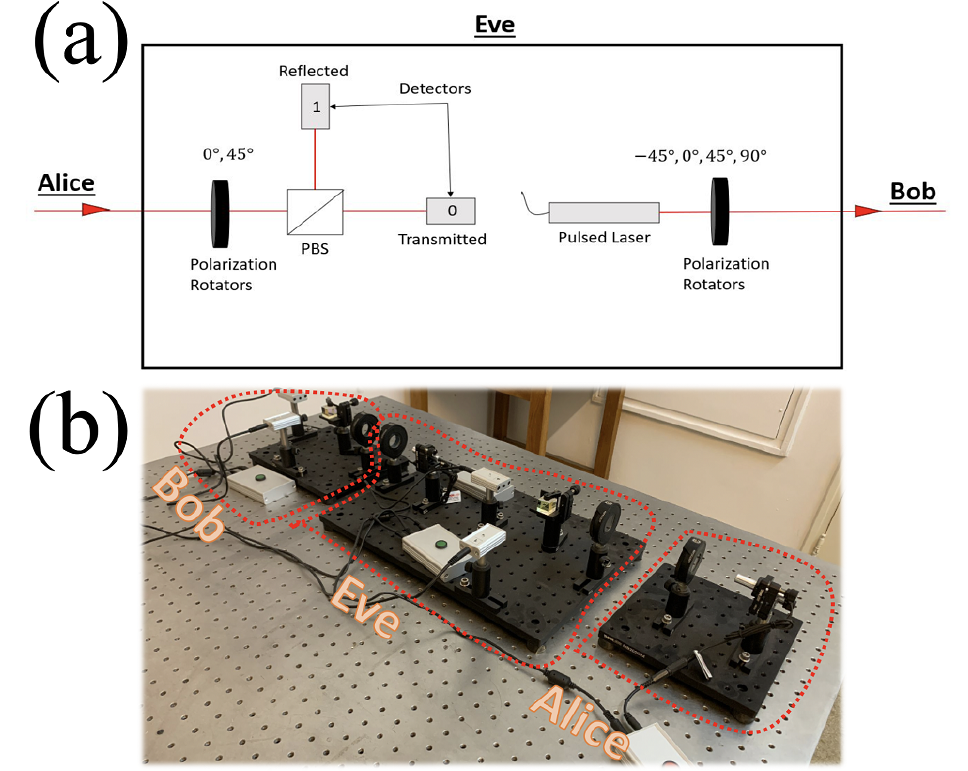
Figure 3. Optical diagram ( a ) and apparatus ( b ) with the eavesdropper Eve between Alice and